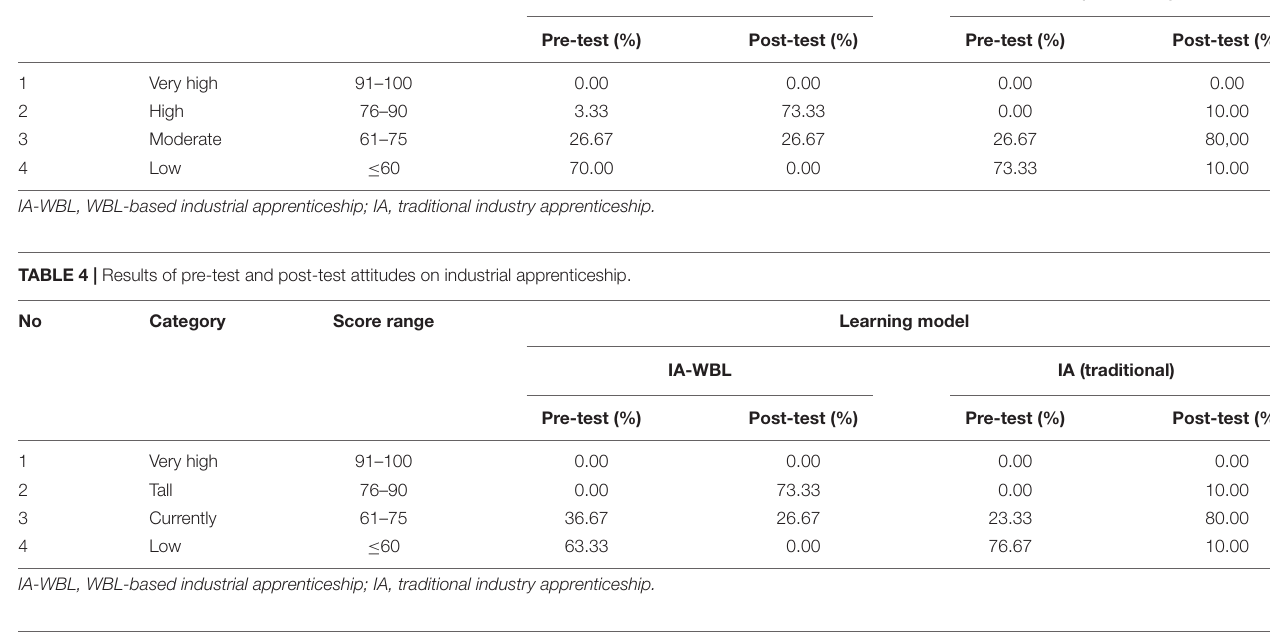
TABLE 5 | Results of pre-test and post-test skills on industrial